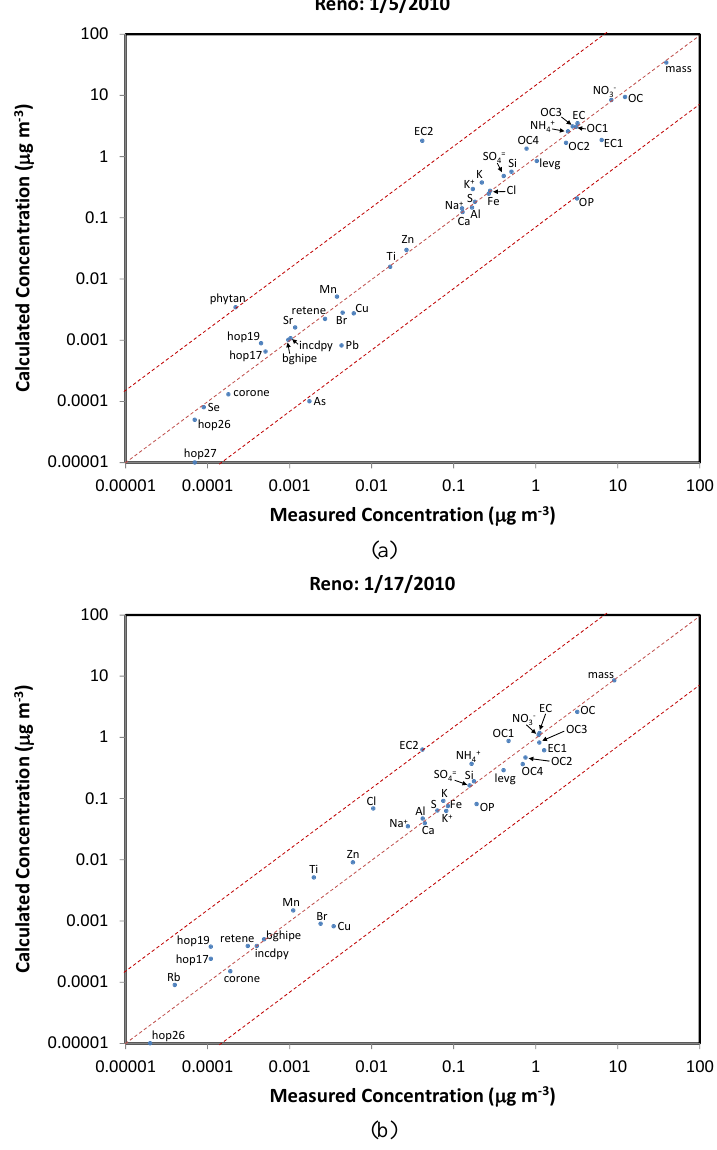
Fig. 7. Comparisons of EV-CMB calculated versus measured PM 2 . 5 species for: (a) 5 January 2010 and (b) 17 January 2010 samples from the Reno monitoring site (RENO C). See Supplement Table S0 for definitions of organic species